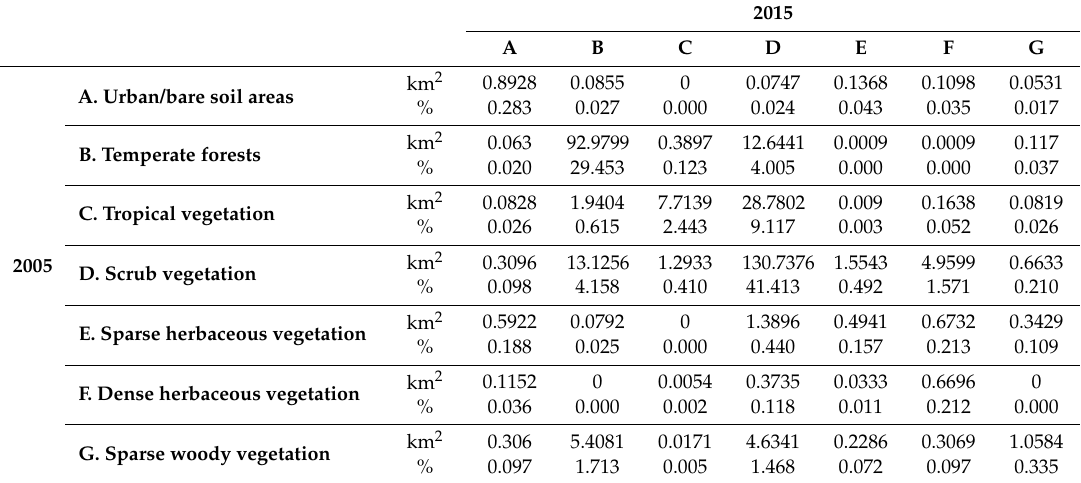
Table 15. Matrix of land use-cover changes from 2005 to 2015, in Natural Protected Area Altas Cumbres (NPAAC). Victoria, Tamaulipas,